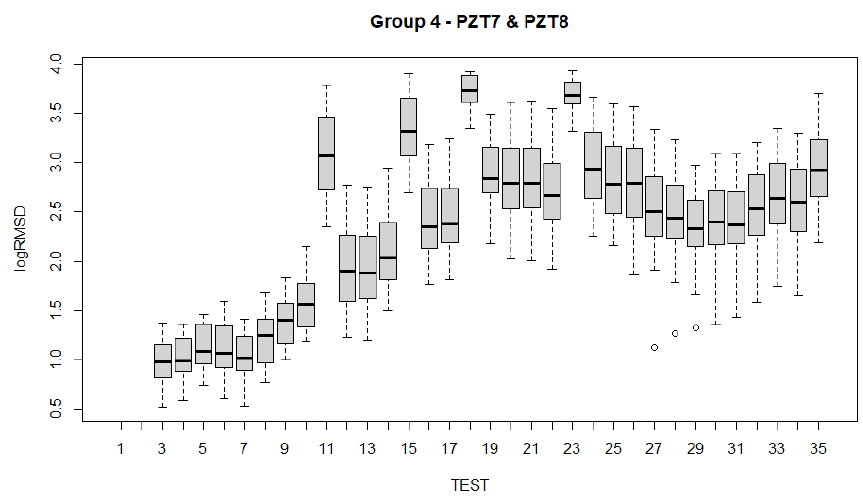
Figure 20. Boxplot for sensors of group 3.